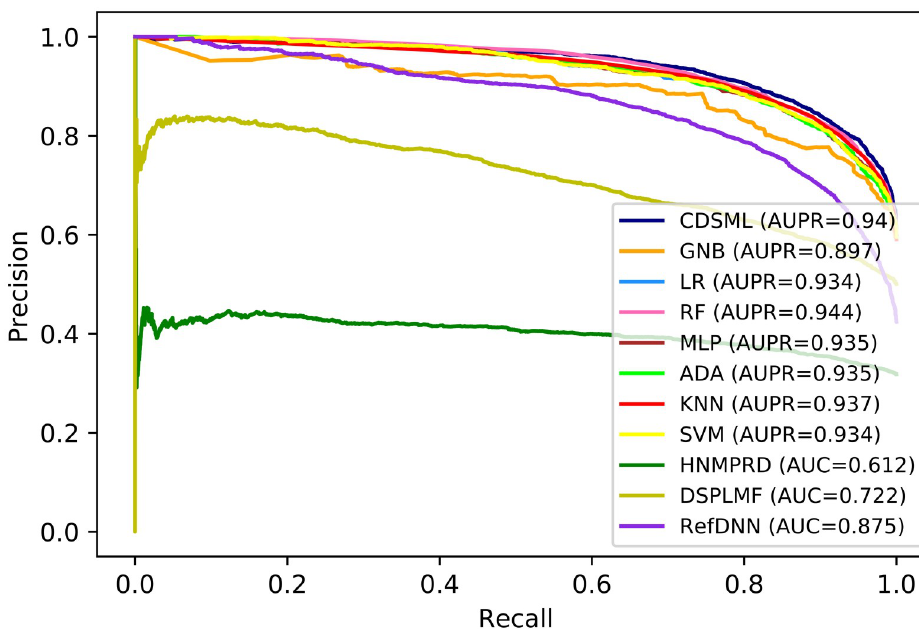
Fig 6. The Precision-Recall curve of all classification methods on GDSC dataset.